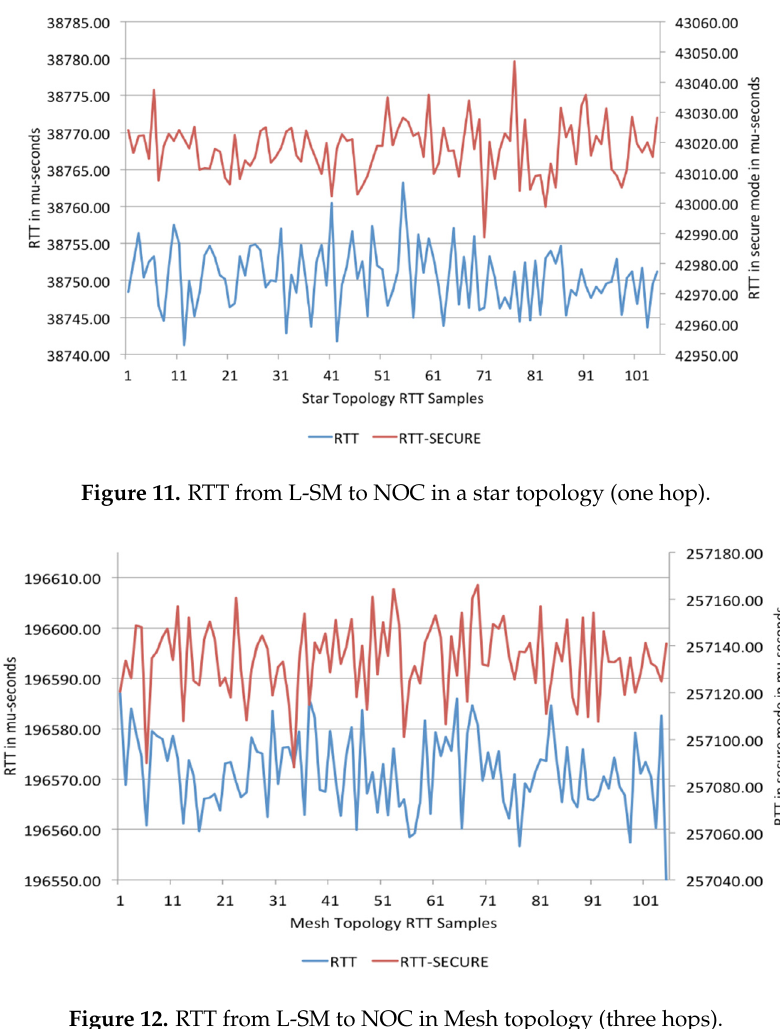
Figure 12. RTT from L-SM to NOC in Mesh topology (three hops).